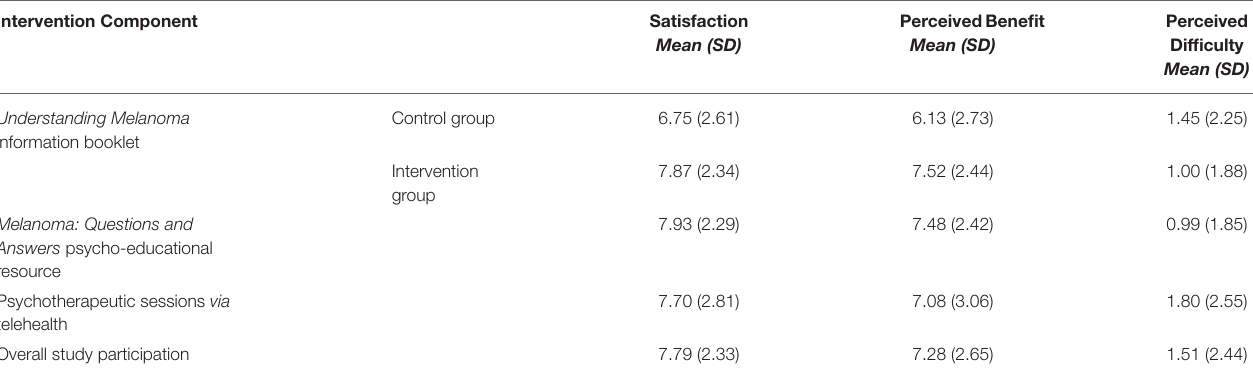
TABLE 2 | Mean perceived satisfaction, benefit, and difficulty of study components. Each component was rated from 0 (“not at all”) to 10 (“extremely”). Intervention